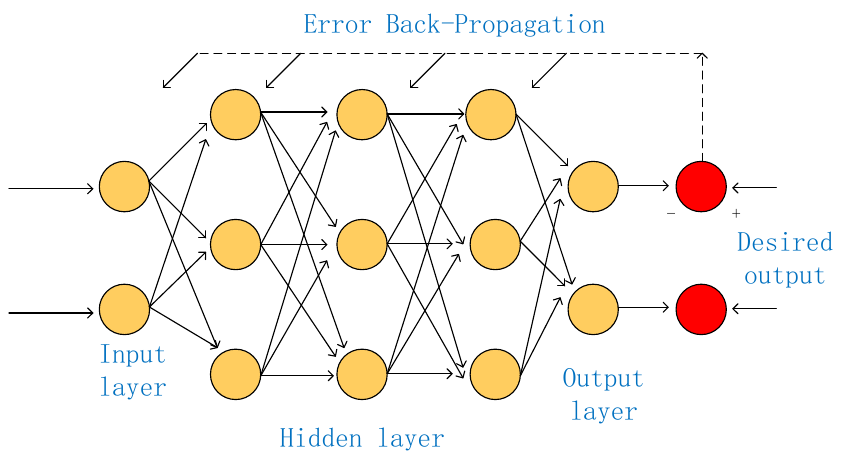
Figure 1. Structure of BP neural